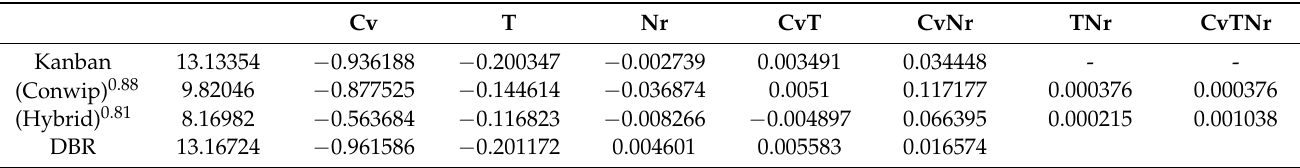
Table A7. Regression coefficient for real factors-process without